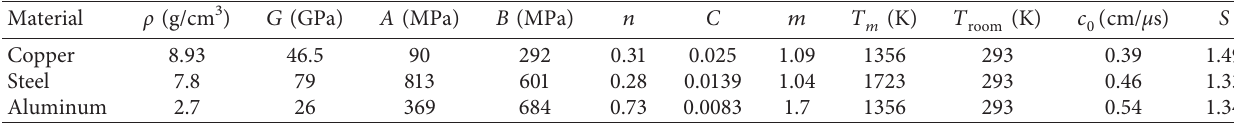
Table 3: Material parameters for liner.